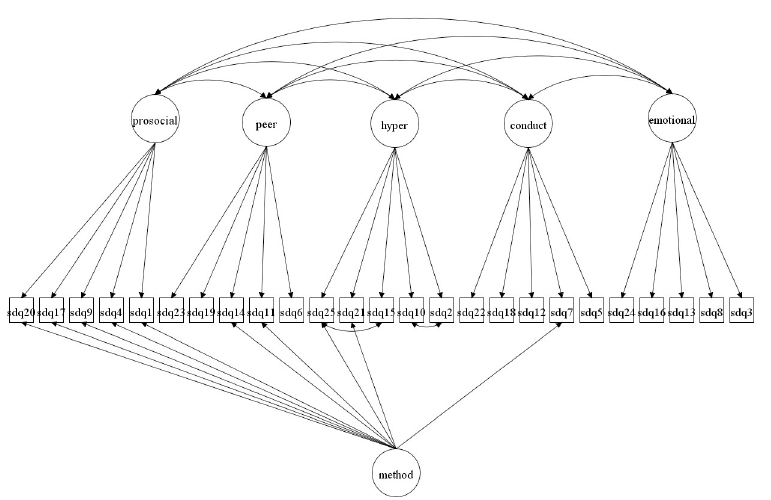
Fig 15. 5-factor model with separate method factor and minor factors (Model